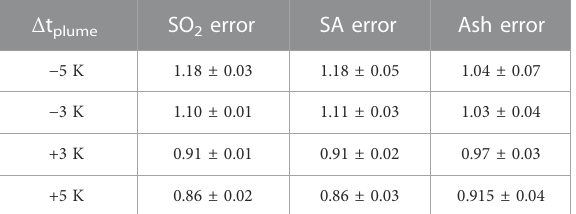
TABLE3Estimatederrorsassociatedwithplumetemperature.Expressedas the ratio of the retrieved SCD over a reference dataset with Δ t plume = 0 K. Δ t